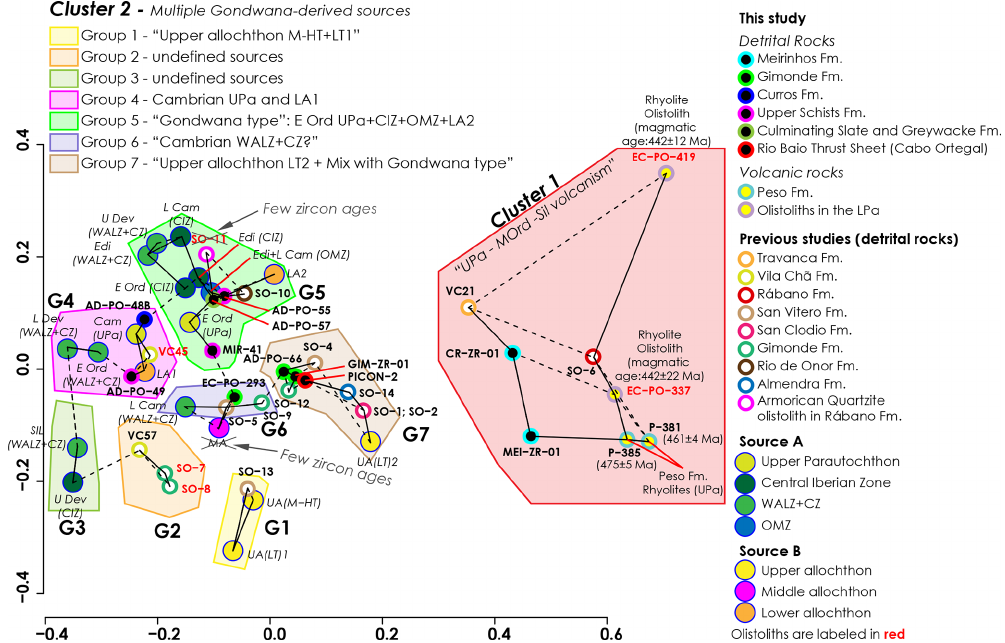
Figure 11. MDS diagram for the samples studied and the reference populations in the autochthon and allochthon, with the differentiation between Cluster 1 (Fig. 12) and the seven groups of Cluster 2 (Fig. 13). Data to construct this plot are provided in the Tables S18 and S19. See more details on how this diagram was built in the Supplement.